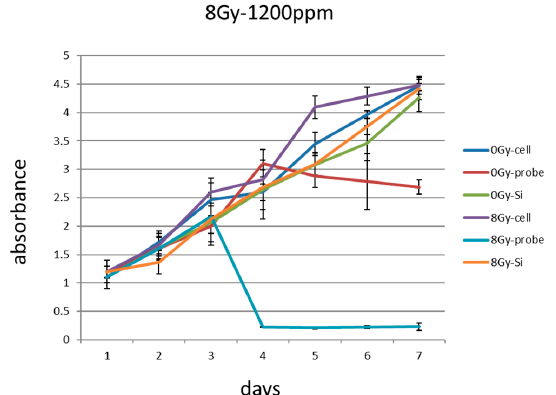
Figure 8. Day 1: passage the SK-BR3 cells, Day 2: add PCSN probes or silica to the cell medium, Day 3: irradiate the cells (8 Gy). In subsequent cell viability assays, the combination of 1200 ppm PCSN probes and irradiation for 24 h at 8 Gy resulted in reduced SK-BR3 cell absorbance. The y -axis represents the absorbance unit (450 nm). Radiation dose: 0 Gy or 8 Gy; Cell: SK-BR3 cell; Probe: containing PCSN probe; Si: containing PCSNs.